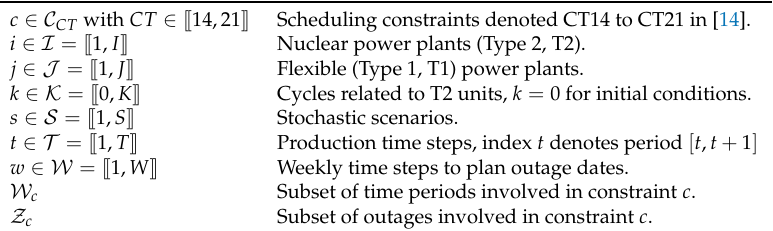
Table 1. Definitions and notations—the sets and